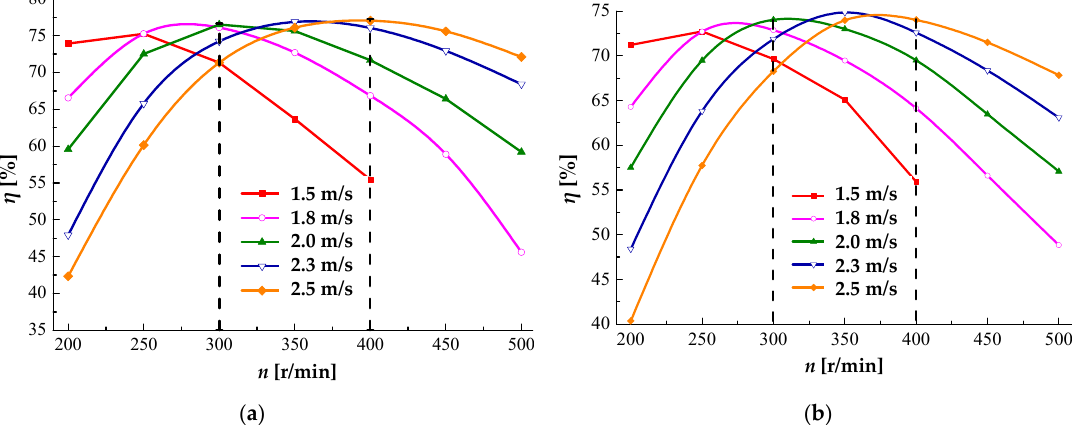
Figure 6. Influences of different rotational speed on efficiency of the water turbine: ( a ) Scheme A and ( b ) Scheme B.